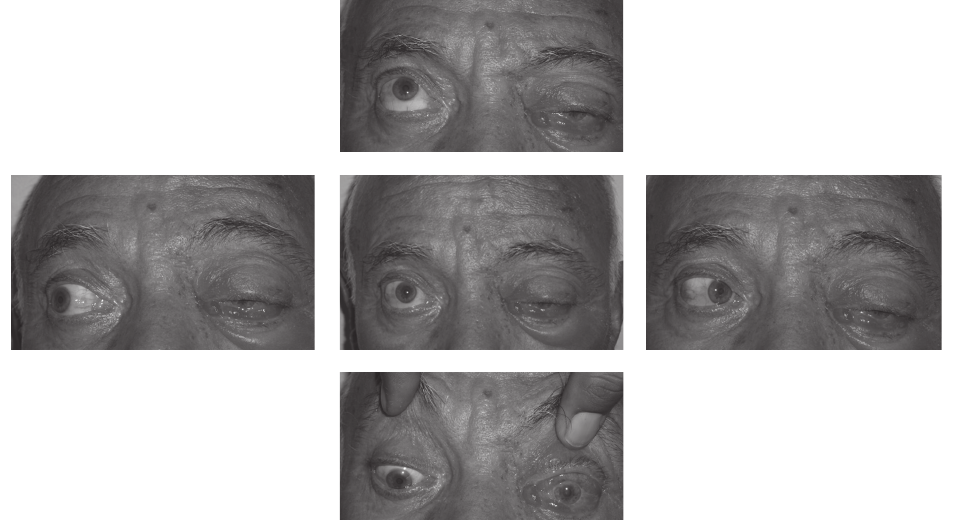
Figure 2: Total ophthalmoplegia and ptosis of the left eye.